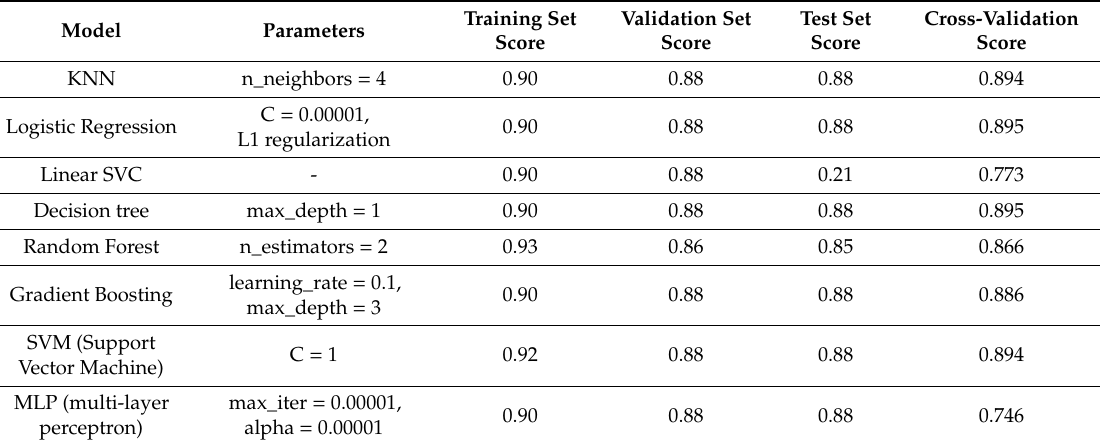
Table 4. Experiment results of training set, validation set, test set, and cross-validation using Dataset